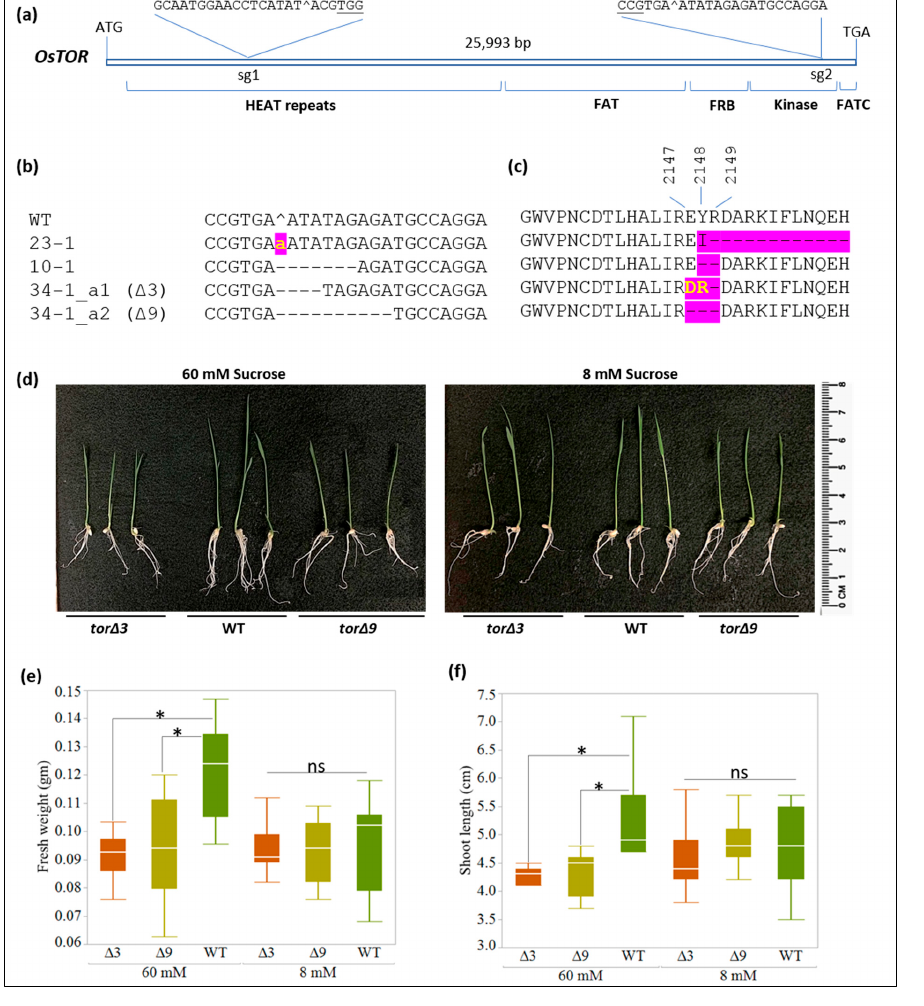
Figure 1. Targeting of OsTOR by CRISPR/Cas9. ( a ) Structure of OsTOR showing sgRNA targeting sites (sg1 and sg2) in the HEAT region and kinase domain sequences. Protospacer adjacent motif (PAM) is underlined and the predicted double-stranded break (DSB) site is indicated (ˆ). ( b ) Alignment of the targeted OsTOR sequences of the mutant lines and the wild-type (WT). Yellow small letter indicates insertion and dashed line show deletions. ( c ) Predicted TOR protein sequences showing changes in the highlighted area. The amino acids affected by targeting (2147–2149) are indicated. Yellow large letters indicate substitutions and dashed lines show deletions. ( d ) Representative 9-d-old os tor (harboring ∆ 3 or ∆ 9 mutations) and WT seedlings grown in MS 1 media supplemented with 2 60 mM or 8 mM sucrose. ( e , f ) Shoot length and fresh weight of WT and os tor mutants measured in 9-d-old seedlings grown in 60 mM or 8 mM sucrose. Statistical differences ( p < 0.05, n = 10) by Tukey–Kramer test (HSD) are shown as significant (*) or non-significant